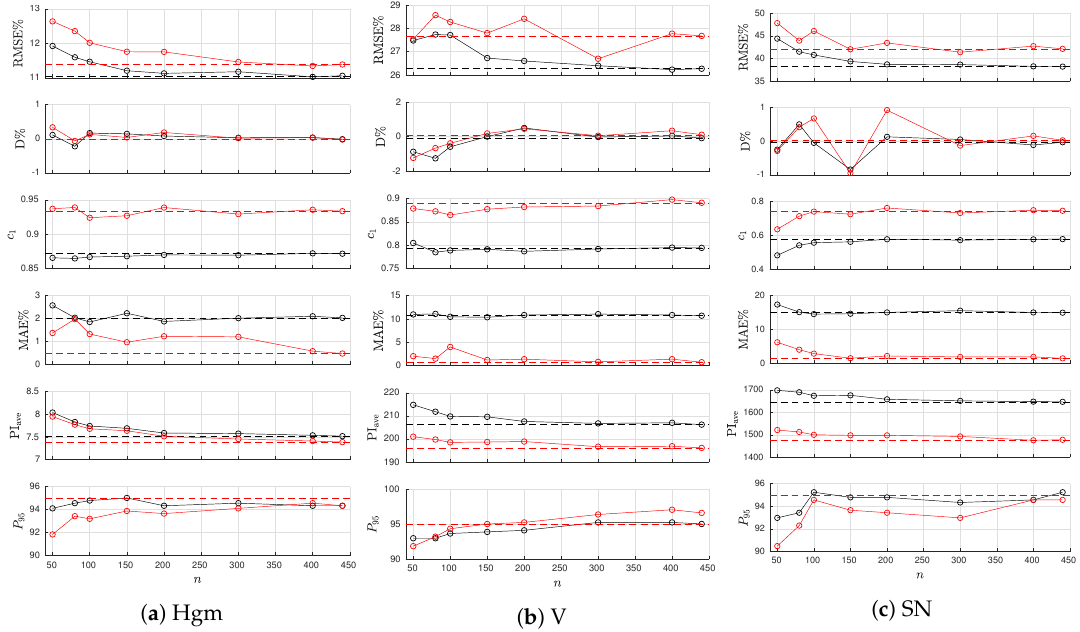
Figure 9. Results of raw predictions (black), corrected predictions (red) with baseline results from large training set LOPO (dashed lines) as function of training set